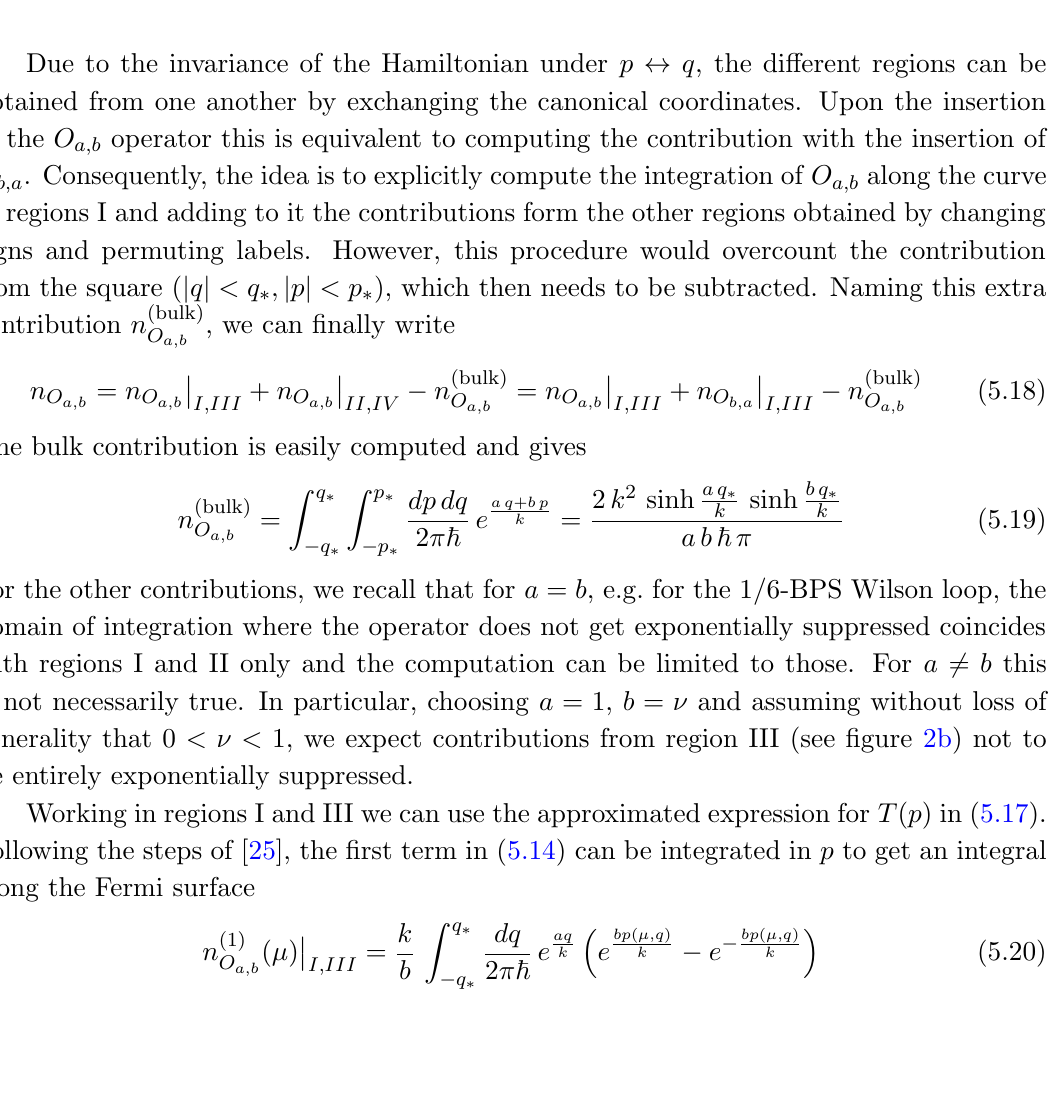
q and separates the regions b